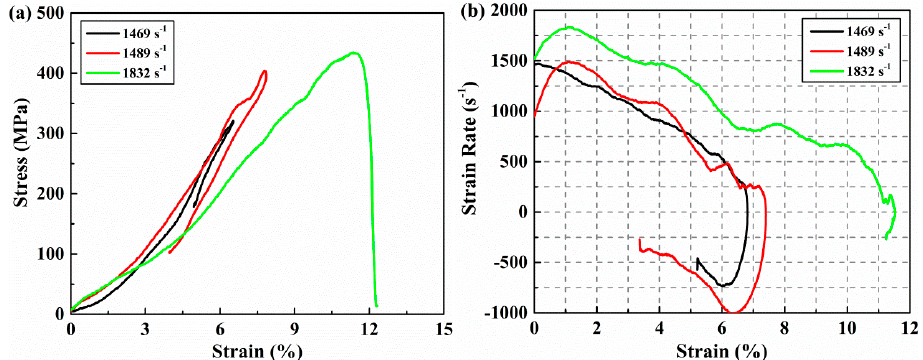
Figure 4. Stress and strain rate as a function of strain at strain rates of 1469/s, 1489/s, and 1832/s during test. ( a ) Stress versus strain. ( b ) Strain rate versus strain.